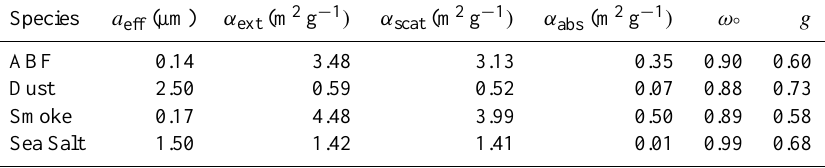
Table 1. Optical properties for dry aerosol particles at 550nm in NAAPS. Species a eff (µm) Dust Smoke 0.17 Sea